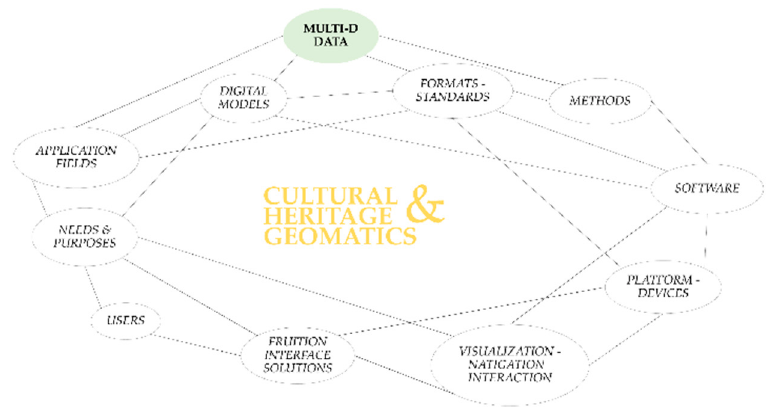
Figure 24. Relations between many deterministic factors turning around the Geomatics approach working in the cultural heritage